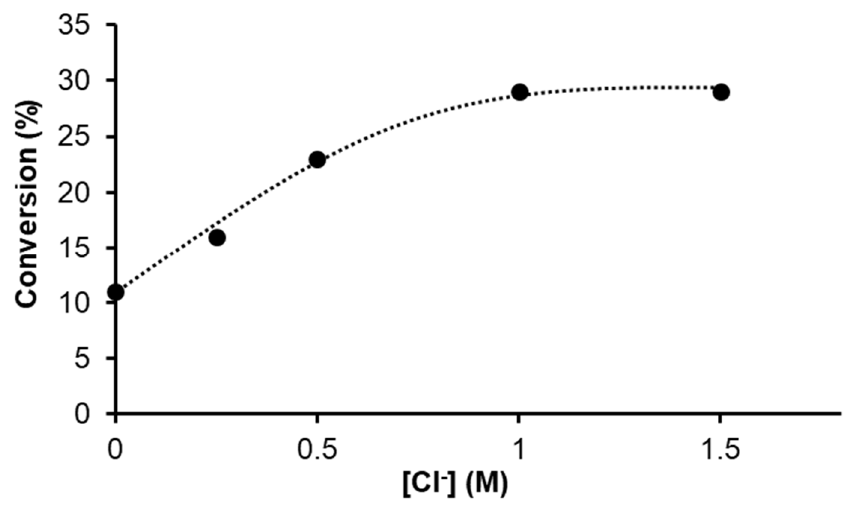
Figure 3. Conversion of phenylacetylene in hydrogenation catalyzed by [RuHCl(CO)( m tppms-Na) 3 ], 1 , as a function of the concentration of added sodium chloride in a water–1,2-DCE biphasic system. Conditions: n(phenylacetylene) = 0.5 mmol, n(Ru) = 0.01 mmol, P (H 2 )= 1 bar, T = 60 °C, t = 2 h, V(aq. chloride solution) = 1 mL, V(1,2-DCE) = 1 mL. Analysis of the reaction mixture by gas chromatography.